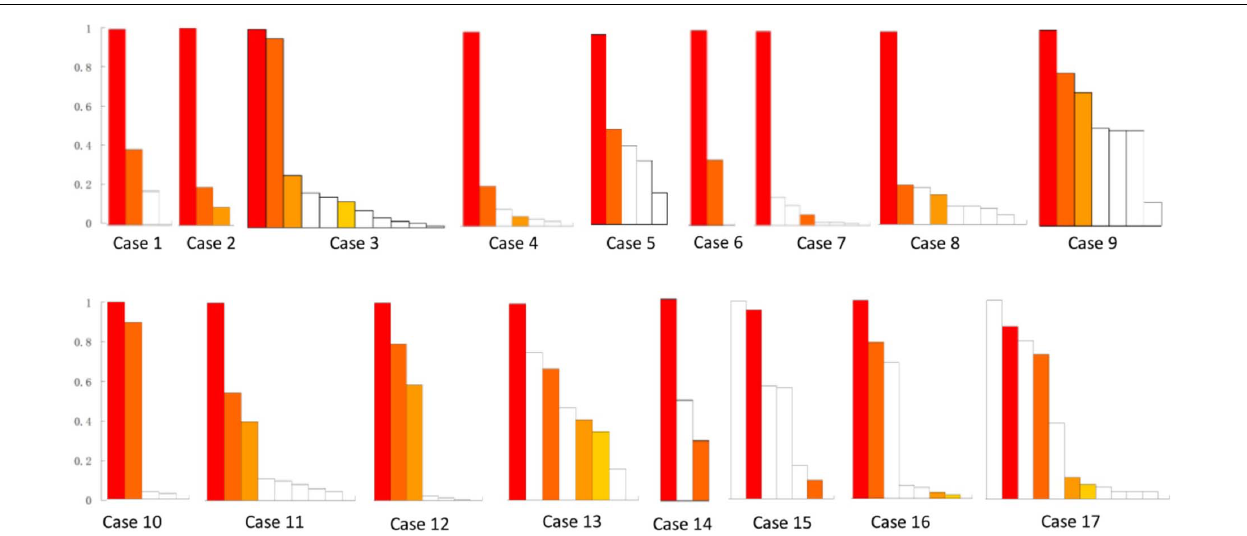
FIGURE 2 | Resective range of contacts with FRs in all of the 17 patients. This figure shows the removed contacts with FRs in each patient. There were 272 FR contacts removed in total. White bars show the reserved contacts with FR discharges. Color bars show the removed contacts with FRs. The same color bars in each patient meant the removed contacts in the same electrode, whereas the different color bars in each patient meant the contacts from different electrodes. Patients 13–17 suffered continuous seizure attack after resective operations. y- axis was the ratio of FRs on each contact. x- axis was contacts in order of the ratio of FR discharges in each patient.